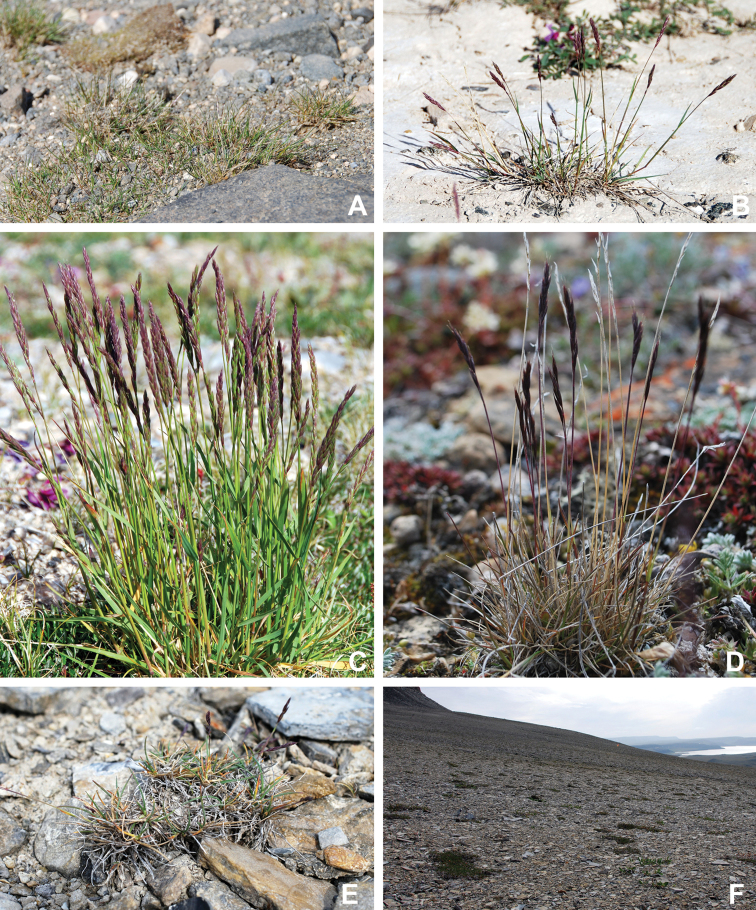
ADeschampsia
sukatschewii habitat, Gillespie et al. 9903BElymus
alaskanus
subsp.
alaskanus habit, Gillespie et al. 9718CElymus
alaskanus
subsp.
hyperarcticus habit, Minto Inlet, NT, 23 July 2010 DFestuca
baffinensis habit EFestuca
hyperborea habit, Gillespie et al. 9863FFestuca
hyperborea habitat, Gillespie et al. 9863. Photos A–C, E, F by J.M. Saarela and D by B.A. Bennett.